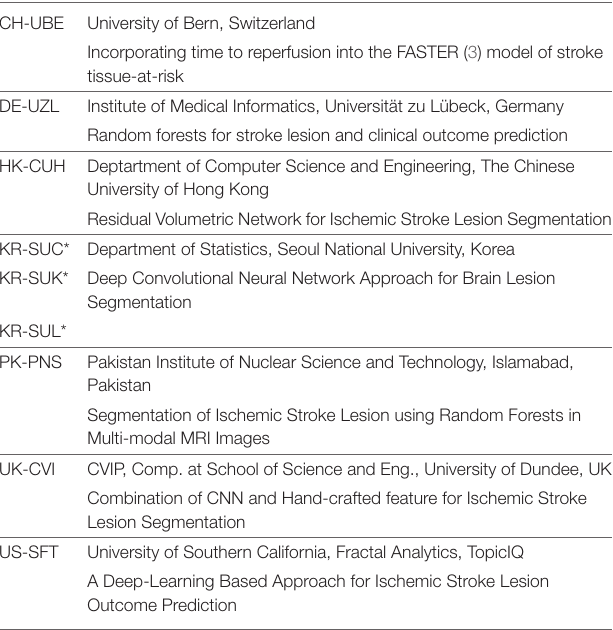
TABLE 2 | Participants of ISLES 2017 (more details and main characteristic of each method see Appendix ISLES17-A1 to